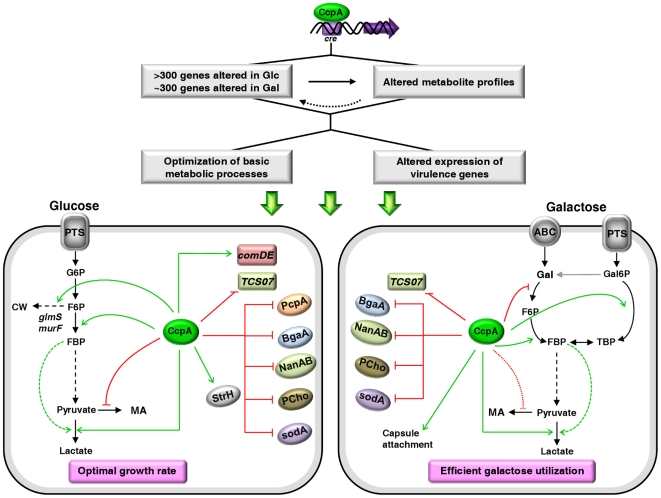
Model for CcpA regulation of basic metabolic processes and virulence factor expression in the presence of Glc or Gal in S. pneumoniae.Transport of carbohydrates through the multi-protein phosphoenolpyruvate phosphotransferase system (PTS) ensures a typical PTS-mediated signal transduction pathway for CcpA regulation. CcpA-mediated regulation results in altered expression of genes involved in carbohydrate metabolism and classical virulence factors, including cell wall associated proteins, transcriptional regulators and phosphorylcholine. Repression and activation are represented by red and green arrows, respectively. Dashed lines indicate metabolic regulation. G6P, Glucose 6-phosphate; F6P, fructose 6-phosphate; CW, cell wall; MA, mixed-acid fermentation; PcpA, choline binding protein PcpA; BgaA, beta-galactosidaseA; NanAB, neuraminidases A and B; PCho, Phosphorylcholine; SodA, superoxide dismutase, manganese-dependent; StrH, β-N-acetylhexosaminidase; TCS07 and ComDE, two-component systems.